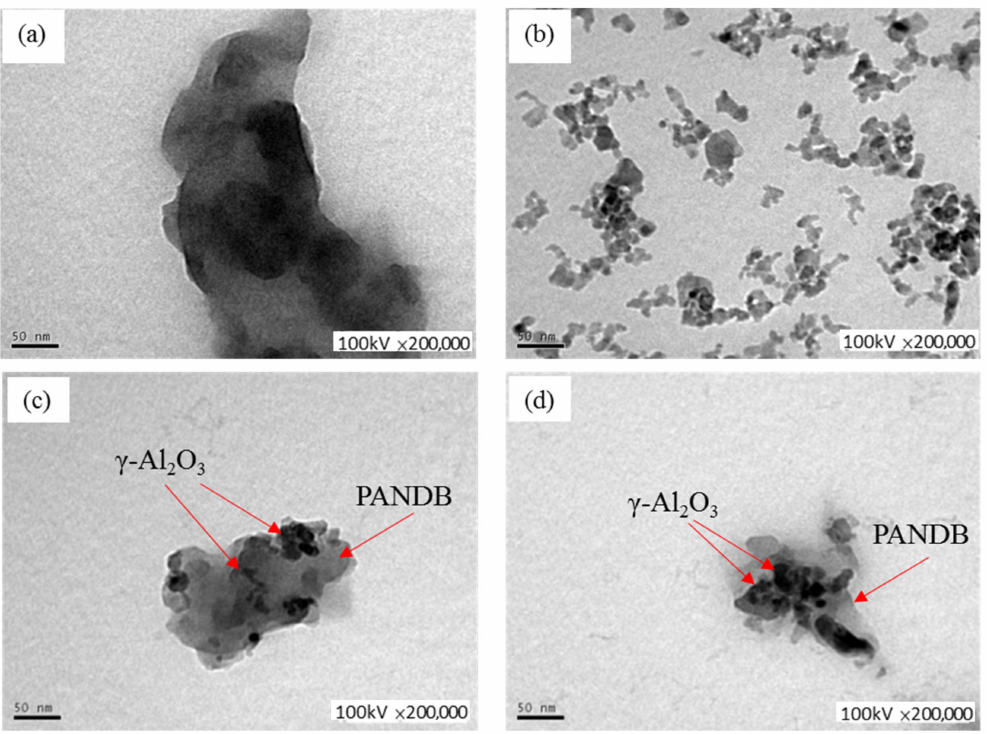
Figure 5. TEM images of ( a ) pure PANDB, ( b ) γ -Al 2 O 3 , and conductive PANDB/ γ -Al 2 O 3 core–shell